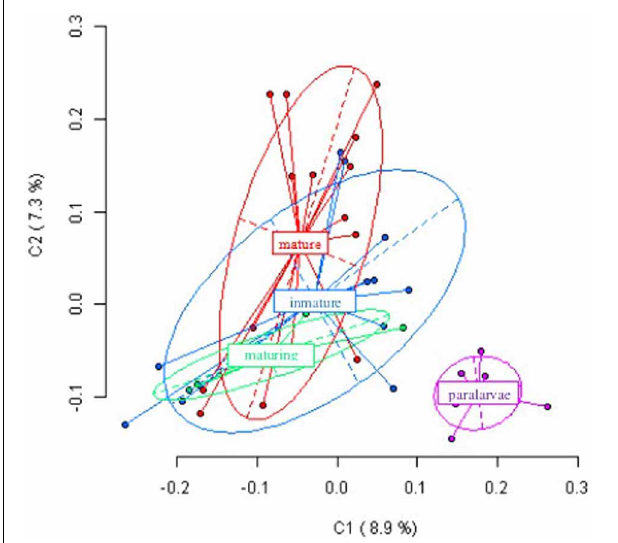
FIGURE 2 | Results from Principal Coordinates Analysis (PCoA) for the epigenetic differentiation between immature, maturing, adult and paralarvae samples. The first two coordinates (C1 and C2) are displayed with the indication of the percentage of variance explained in brackets. Scores represent individual samples. Labels indicate the centroids of each group. Ellipses represent the dispersion associated to each value. The long axis of the ellipse shows the direction of maximum dispersion and the short axis shows the direction of minimum